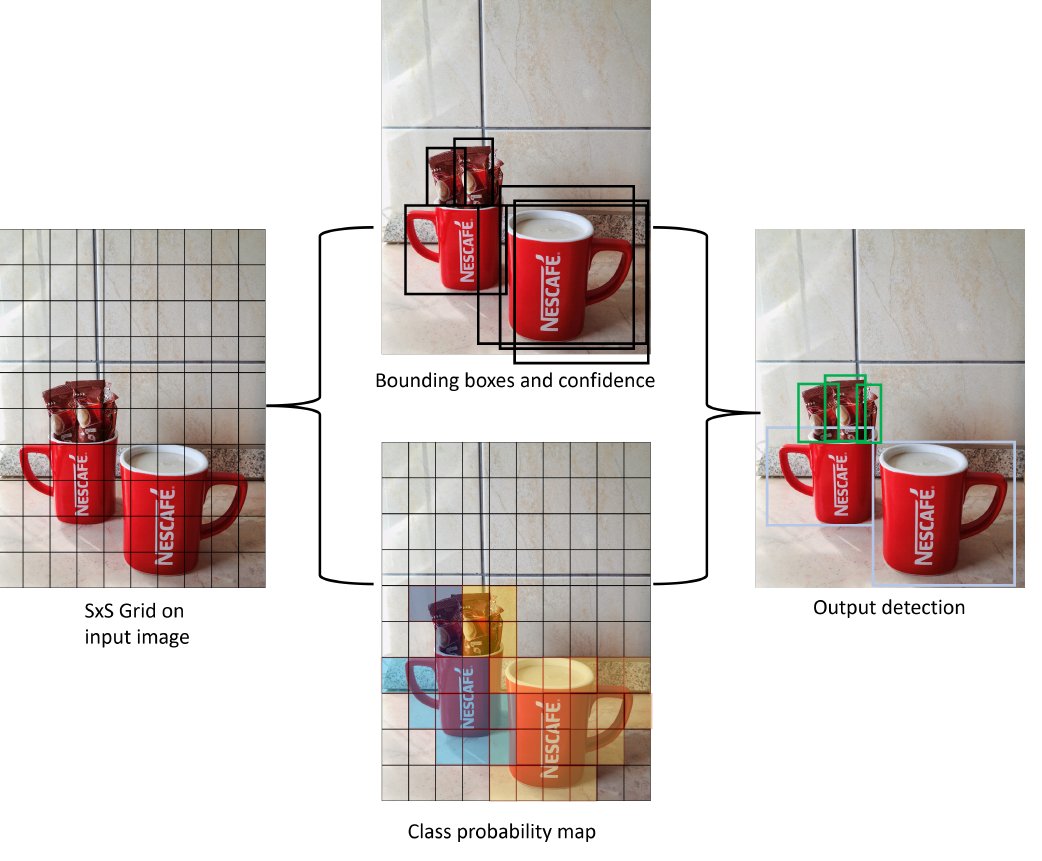
Figure 14. An ilustration on YOLOv5-based object detection. YOLOv5 Structure